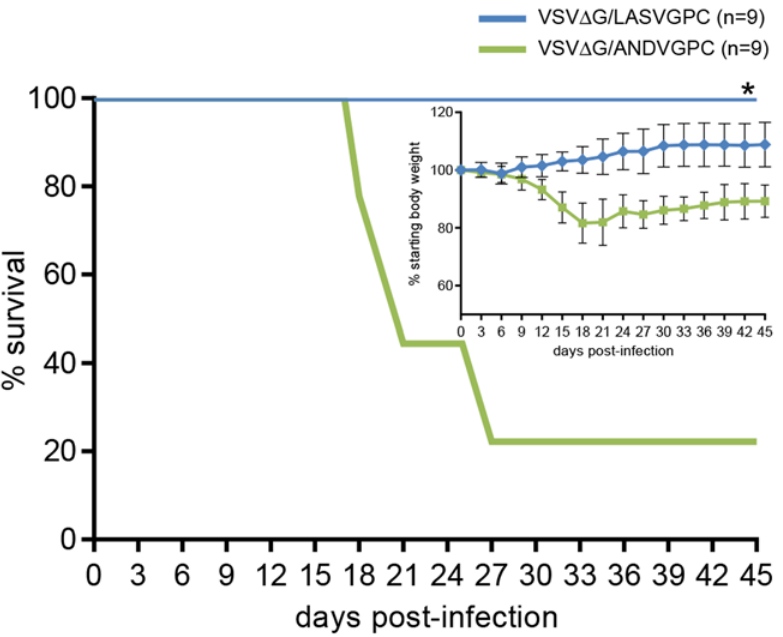
Fig 3. VSV Δ G/LASVGPC protects strain 13 guinea pigs from infection / disease following challenge with a Malian Lassa virus isolate. Adult, inbred strain 13 guinea pigs were immunized with 1 x10 6 pfu of VSV Δ G/LASVGPC (n = 9) or VSV Δ G/ANDVGPC (n = 9) and challenged 28 days later with Lassa virus strain Soromba-R. Animals were monitored for disease progression including weight loss for up to 45 days. * p = 0.001.